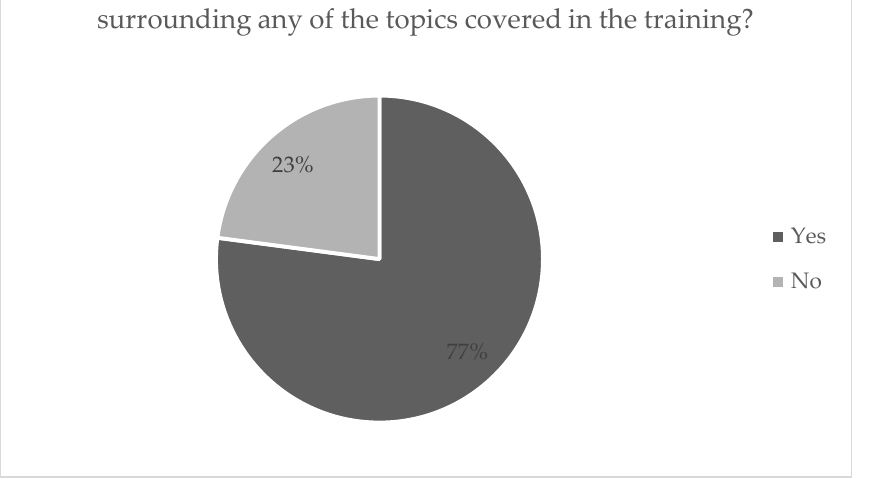
Figure 5. Of the 48 respondents, 77% reported that their facility changed their special pathogen protocols after they had taken the training.